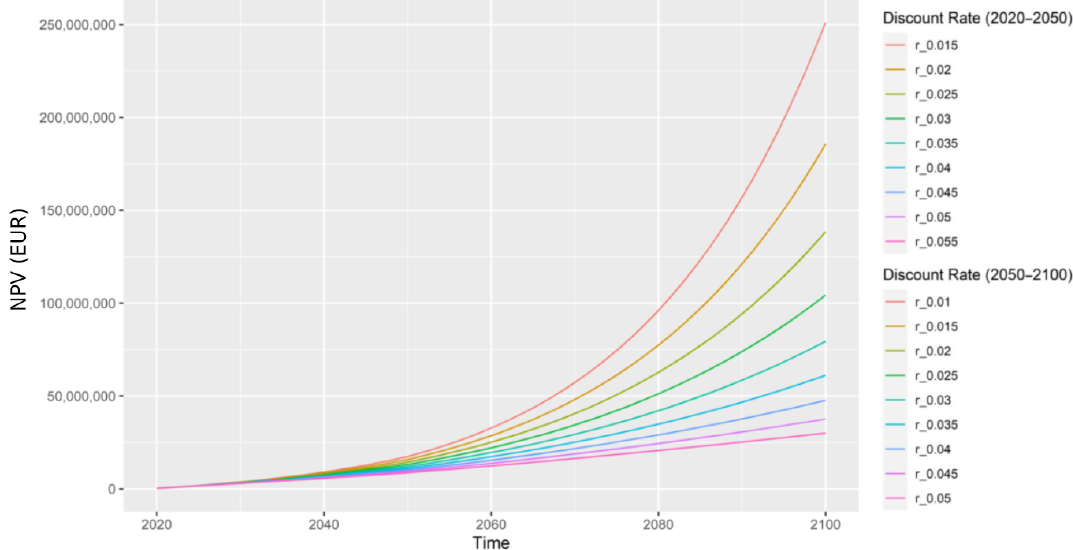
Figure B1. Sensitivity analysis of NPV using a variable discount